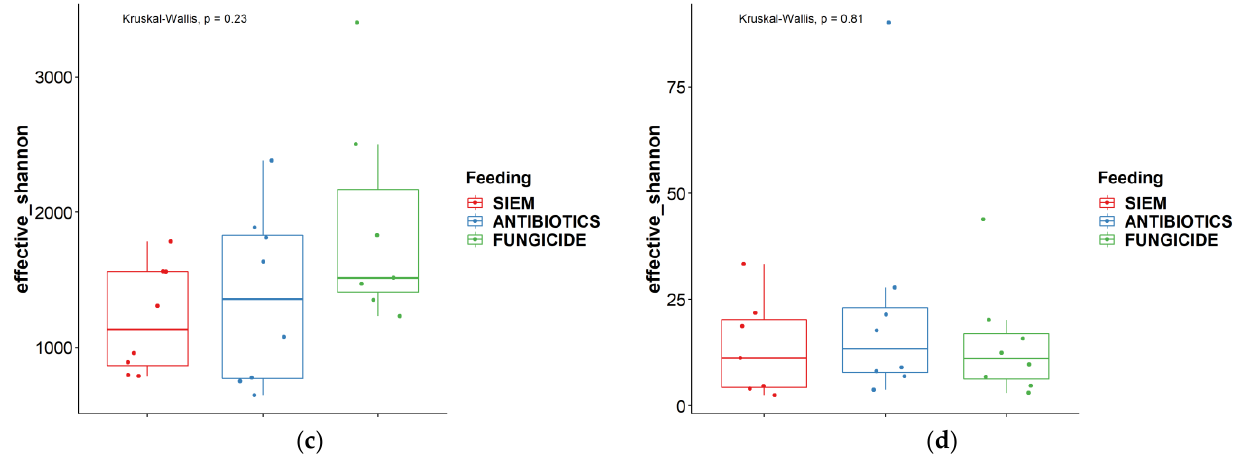
Figure 2. Alpha diversity measures different treatments ‘observed features’ and ‘effective Shannon’; ( a ) + ( c ) = bacteria, ( b ) + ( d ) = fungi.